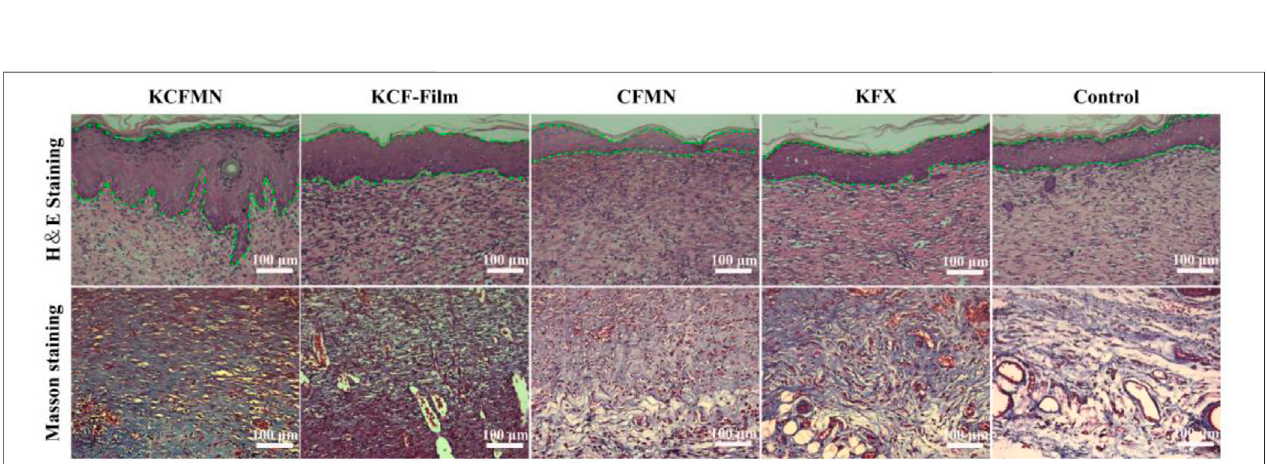
FIGURE 6 | H&E and Masson ’ s trichrome staining of wound skin tissues. Scale bars represent 100 μ m.